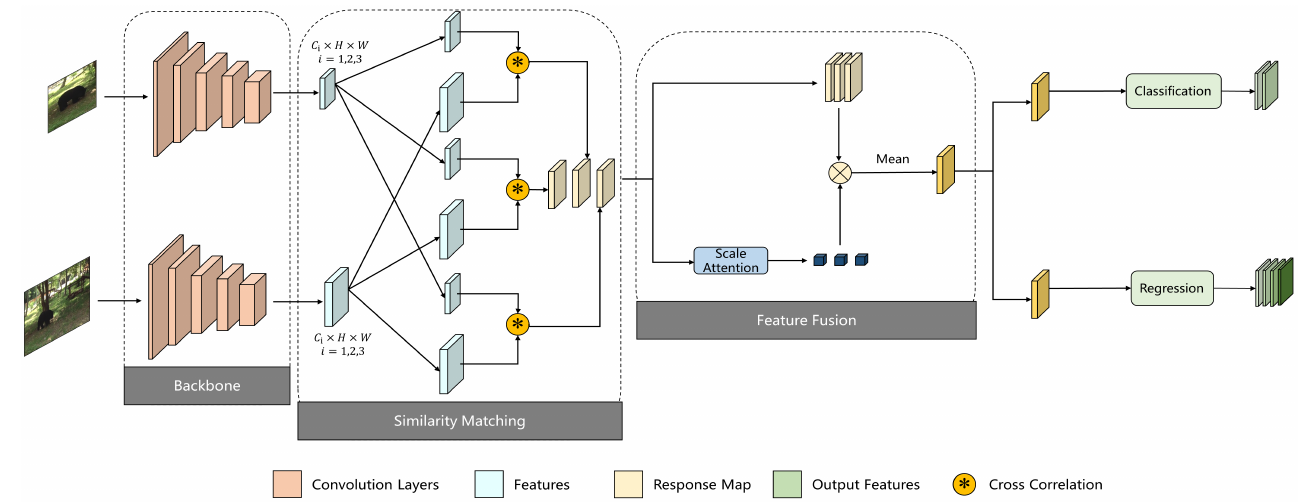
Figure 3. The overall architecture of the proposed Siamese Feature Fusion Network (SiamFFN). The modified ResNet-50 outputs three different levels of feature maps. DW-Xcorr is responsible for calculating the similarity between them and outputting three similarity response maps. Then, we use a novel scale attention to fuse multi-level feature maps according to their semantic importance. Finally, it is decoded to obtain the final classification and regression maps.